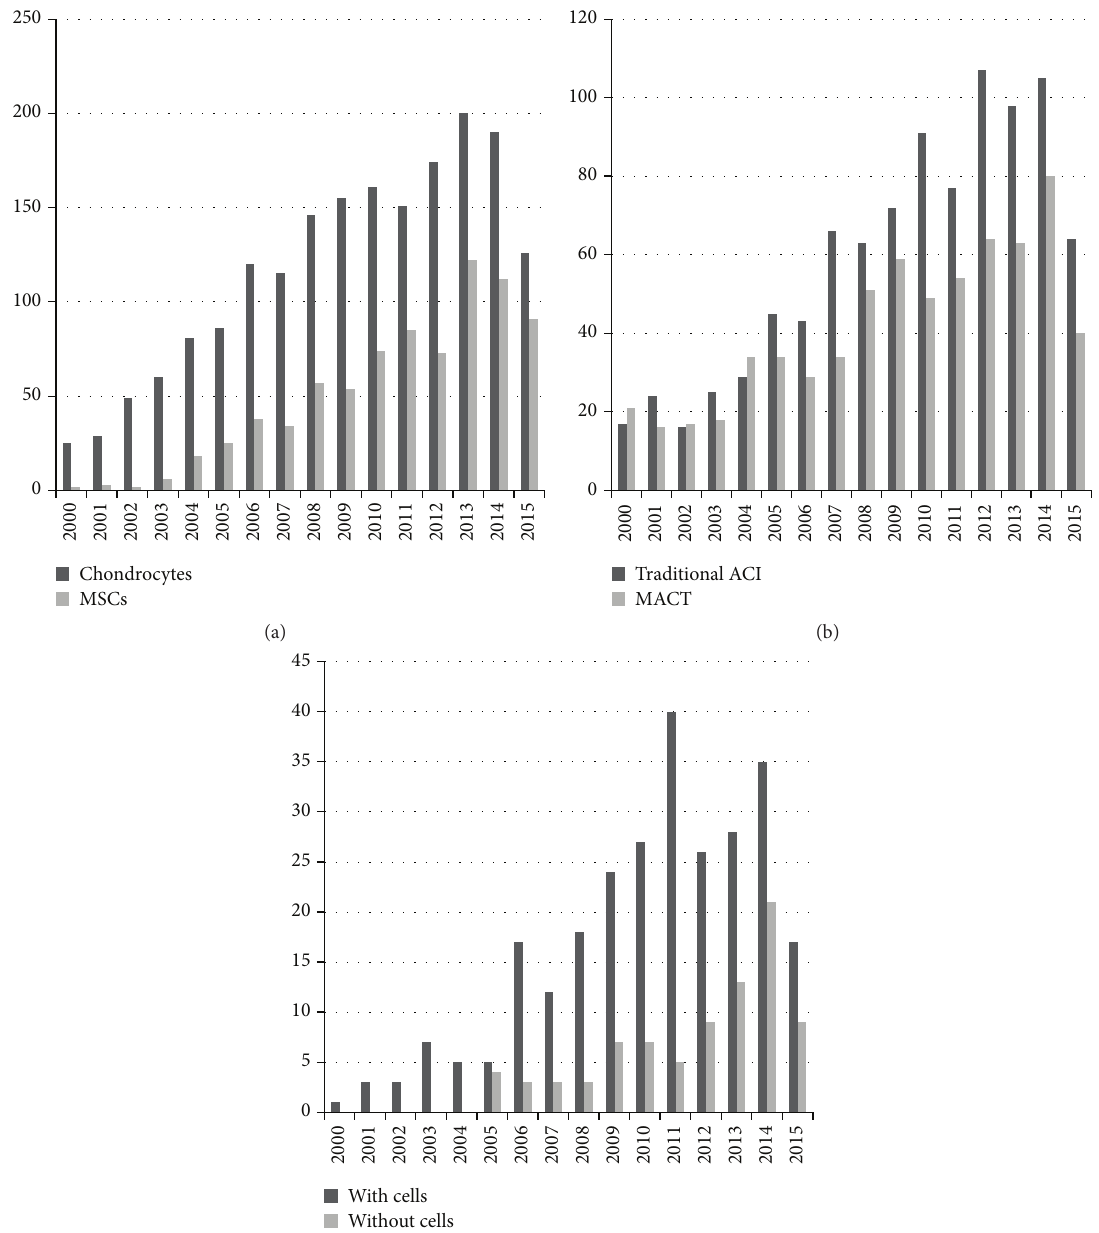
Figure 2: The number of published studies on cartilage treatments during the last 15 years. (a)–(c) The number of published studies on chondrocytes and MSCs, traditional ACI and MACT, and treatments with or without cells. MSCs: mesenchymal stem cells; ACI: autologous chondrocyte implantation; MACT: matrix-assisted autologous chondrocyte